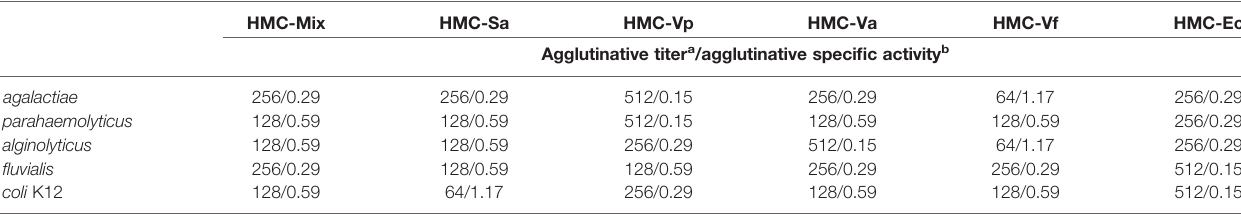
TABLE 2 | Comparison of agglutinative activities of bacteria-binding hemocyanin with 75 m